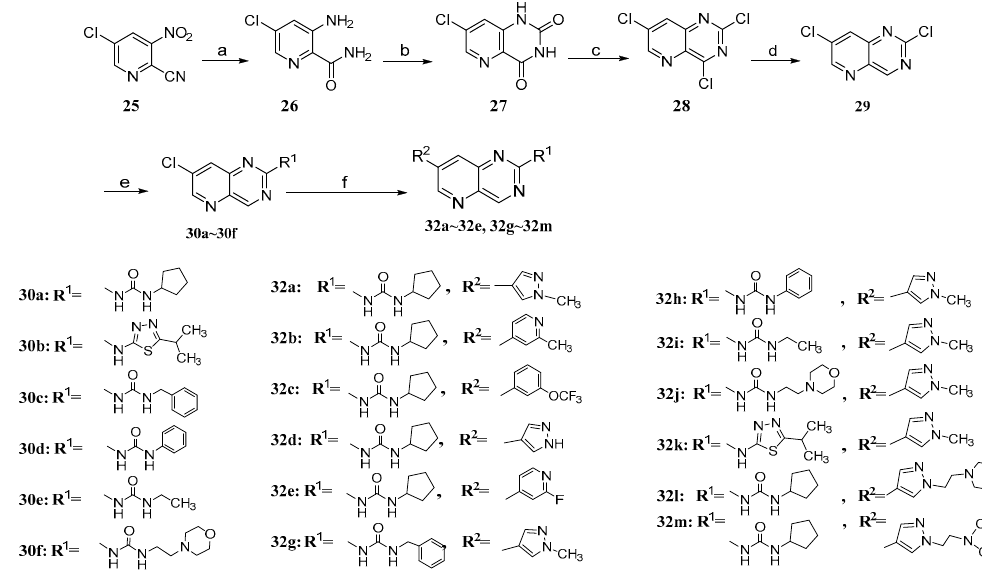
Scheme 3. Preparation of target compounds 32a ~ 32e and 32g ~ 32m . Reagents and conditions: ( a )